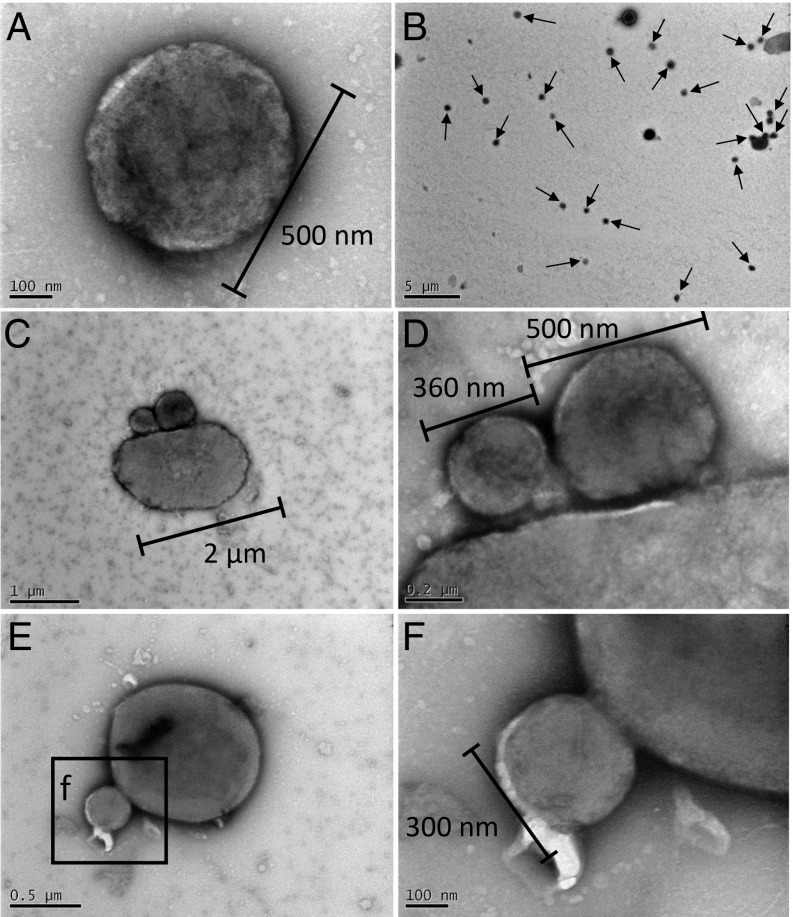
TEM of Nha-C enrichment with Hrr. lacusprofundi ACAM34-hmgA. Small individual cells consistent with being Nha-C (A and B). Arrows mark putative Nha-C cells (B). Small cells that appear to have intact membranes with minimal visible boundary layers separating them from larger cells, consistent with Nha-C associating with Hrr. lacusprofundi (C and D). Small cell that appears to be attached with a possible membrane collar to a large cell (E and F); the morphology is reminiscent of a site of budding (detachment) or possibly, initial stages of fusing after attachment.